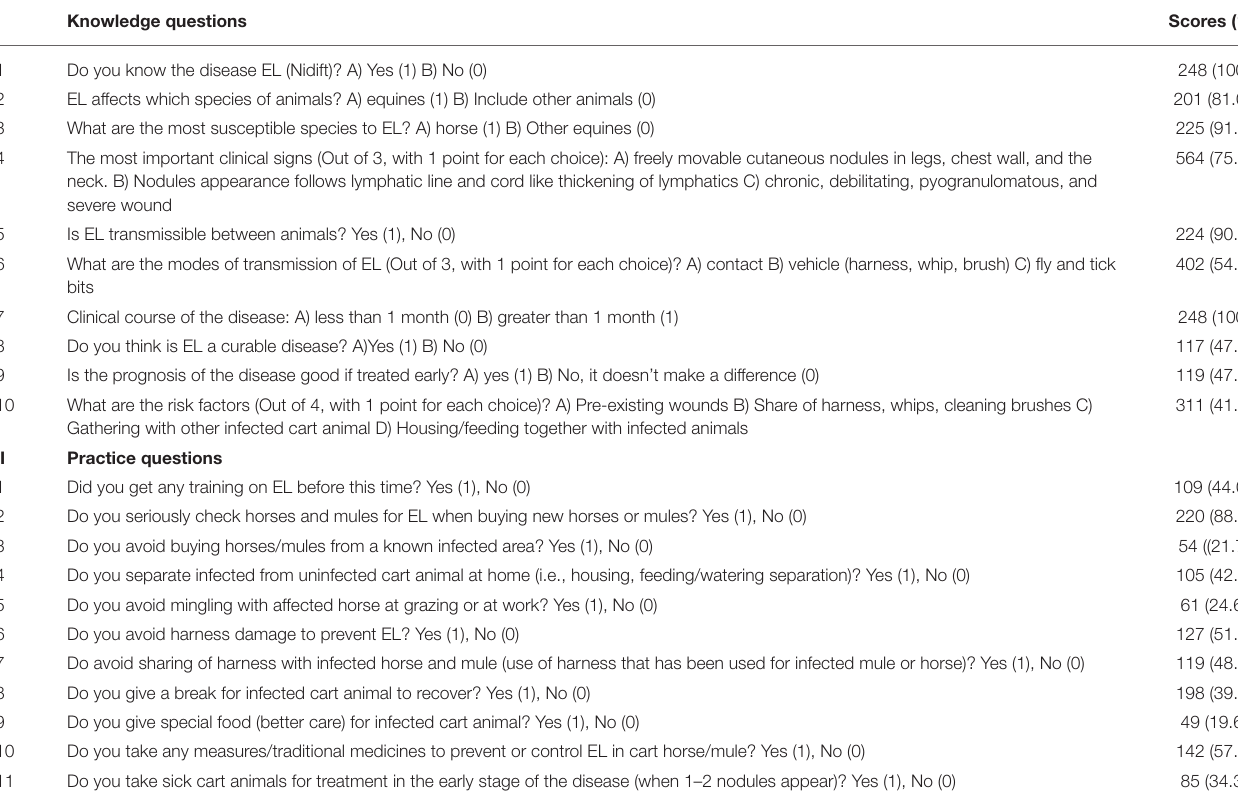
TABLE 6 | Individual knowledge and practices questions’ scores.